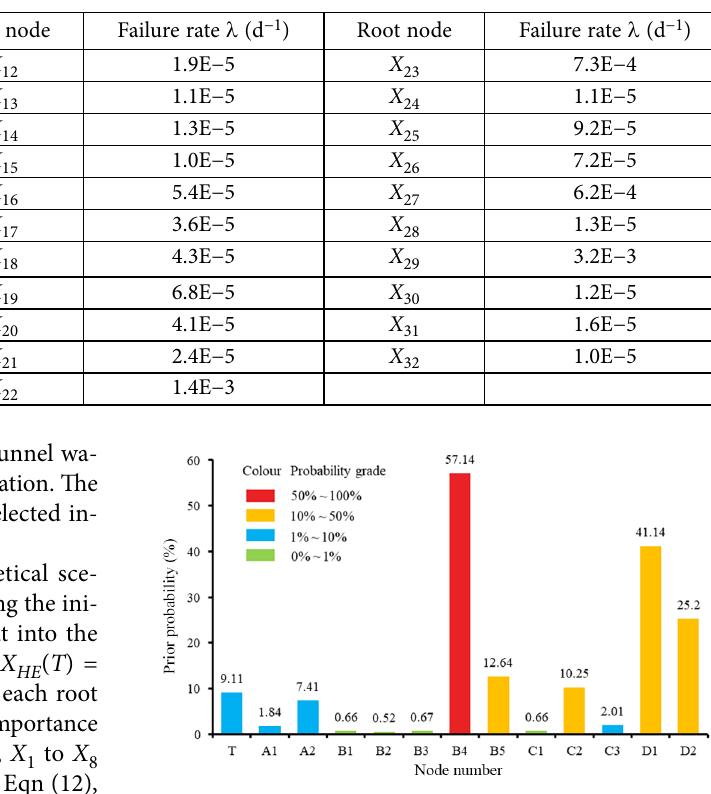
Figure 12. Prior probabilities of leaf node and critical intermediate nodes (probability grade in red indicates very likely, probability grade in orange indicates likely, probability grade in light blue indicates possible, probability grade in light green indicates